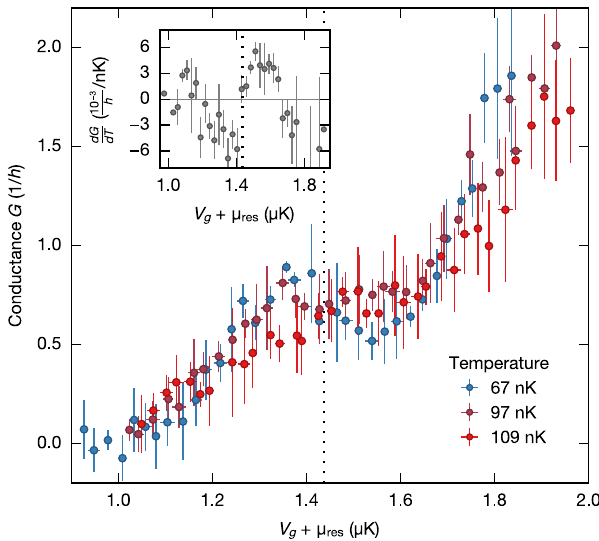
FIG. 4. Smearing conductance by thermal decoherence. Ex- perimental conductance G through a six-barrier lattice of height 0 . 46 ð 2 Þ μ K for three different temperatures as a function of V l ¼ gate potential V , shifted by the reservoir chemical potential μ g res to account for different optical trap frequencies. Inset: Variation of conductance with temperature obtained from a linear fit to temperatures T ¼ 67 , 84, 97, and 109 nK. The sign of dG=dT μ 1 . 44 μ changes across the critical value V g þ res ¼